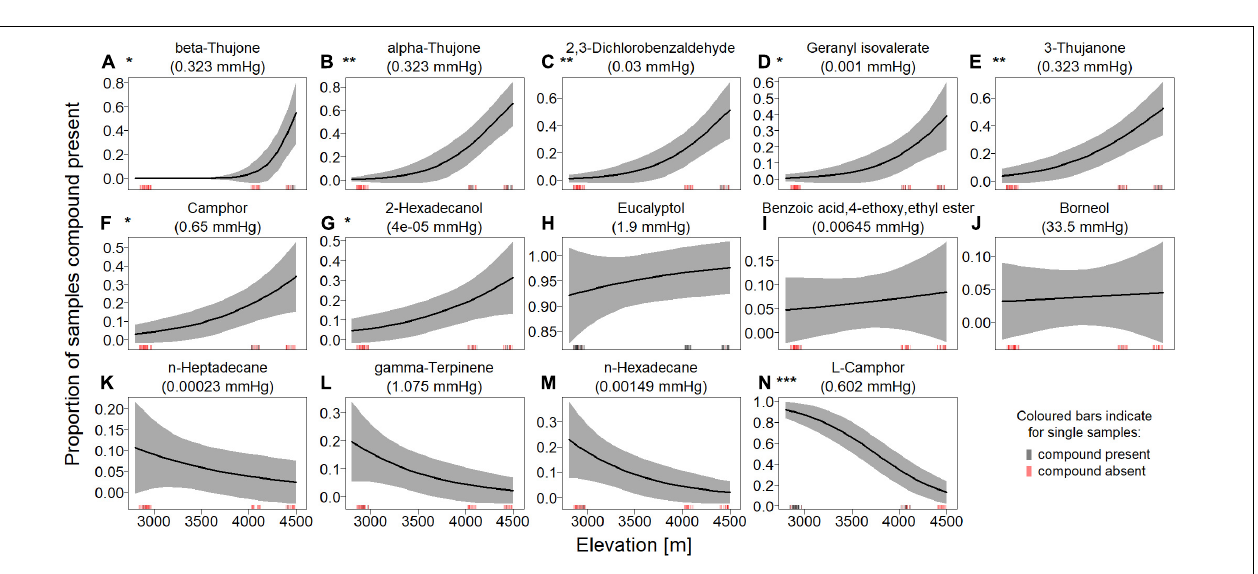
FIGURE 2 | Effect of elevation on presence/absence of different volatile organic compounds (A–N) . Solid lines show the estimated marginal means from the GLM and the gray-shaded area shows the 95% confidence interval. Compounds were sorted from top left to bottom right, according to their slope (on the logit-scale). Raw data is displayed at the lower end of each graph, with red lines denoting that a compound was not detected at a certain elevation and black lines denoting that it was detected (each n = 79). The lines are slightly jittered to avoid overlap. Significant effects are highlighted with common asterisk notation next to the panel